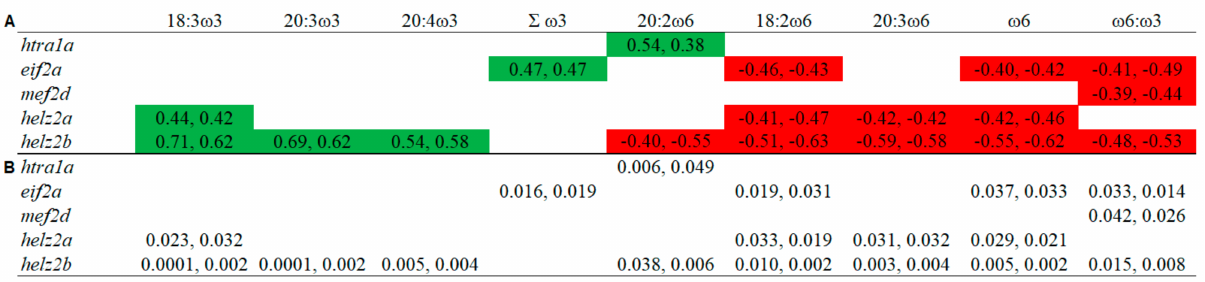
Figure 3. Overlapping Pearson correlations between the liver and muscle analyses. Liver transcript expression (qPCR relative quantity values (RQ)) of GOIs was correlated with liver and muscle lipid composition in Atlantic salmon fed diets with varying ω 6 to ω 3 fatty acid ratios. Statistically significant ( p < 0.05) correlations are shown. Green and red cells signify positive and negative relationships, respectively. Upper panel shows correlation coefficients ( A ), and lower panel depicts p -values ( B ). Commas separated values from the liver and muscle analyses, respectively ( A , B